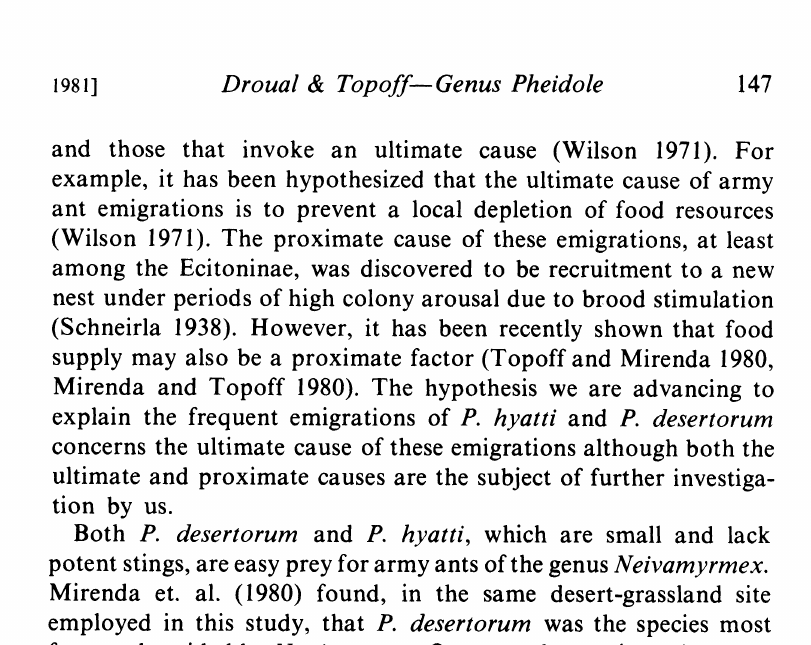
Table 3. Observed army ant raids on colonies of P. h.vatti. Colony Dates of